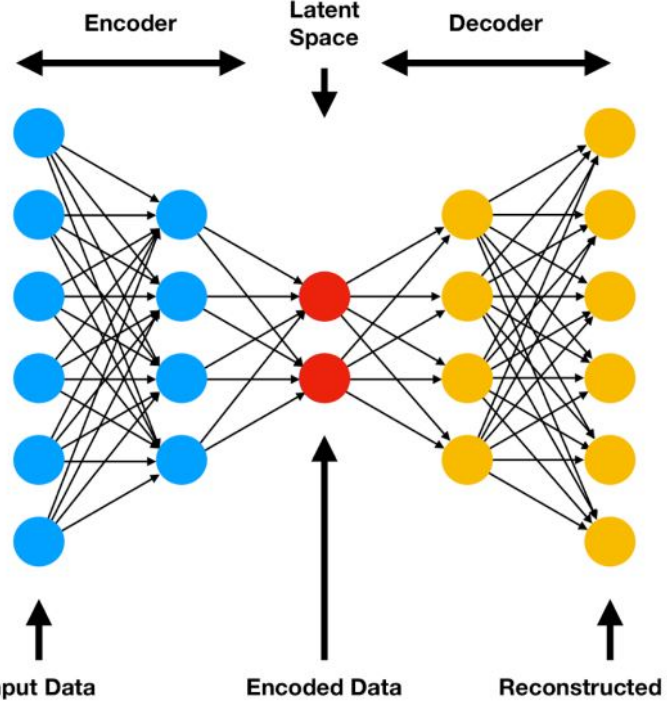
Figure 2. An autoencoder is represented